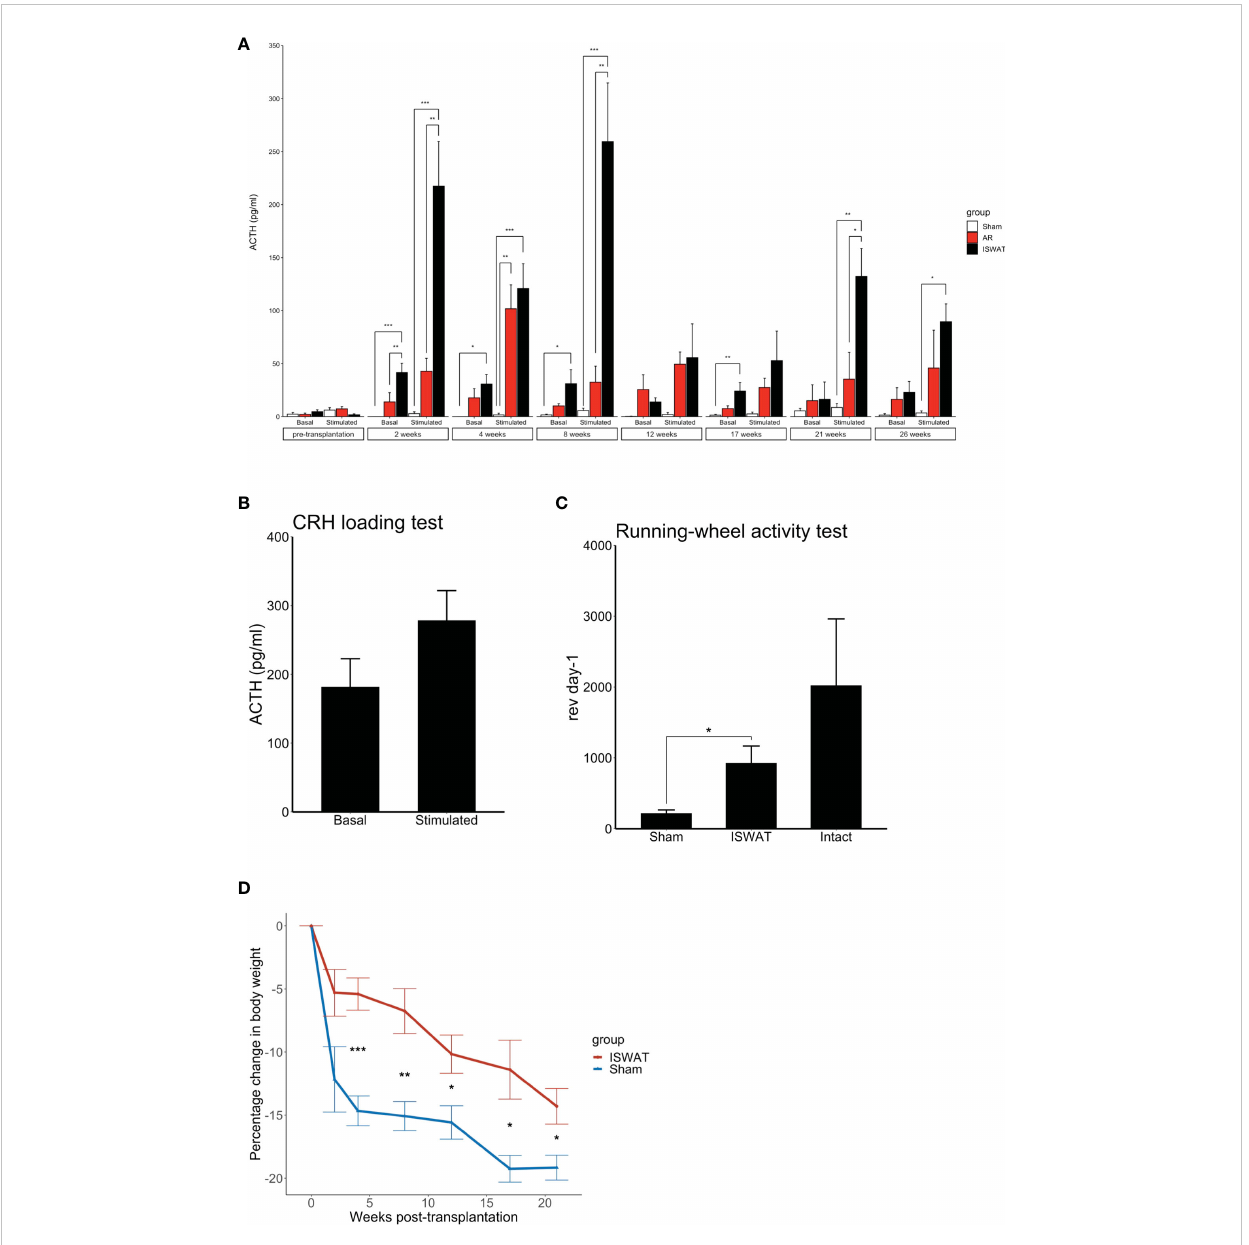
FIGURE 2 Evaluation of grafted mice All data presented as mean ± SEM. *p<0.05, **p<0.01, ***p<0.001. (A) Basal and CRH-stimulated serum ACTH levels in mice subjected to POs transplantation; sham-operated (Sham), avascular region (AR), and ISWAT cohorts. Sham, n=6. AR, n=5. ISWAT, n=6. Statistical assessment, one-way ANOVA with post hoc Tukey ’ s test. (B) CRH loading test in intact SCID mice. n=6. (C) Running-wheel activity test. Sham, n=3. ISWAT, n=3. Intact, n=3. Student ’ s t -test. (D) Percentage change in body weight, ISWAT and Sham mice. Percentage change in body weight, abscissa; time course, ordinate. Student ’ s t